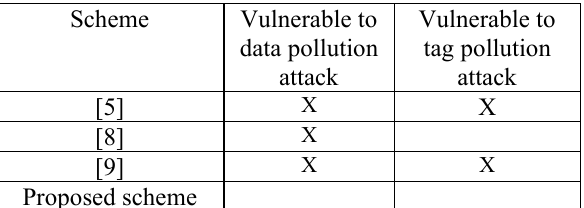
Table 3. Comparison between our scheme and others in terms of in terms of vulnerability against pollution attacks.